Question: Summarize what this figure shows in one sentence.
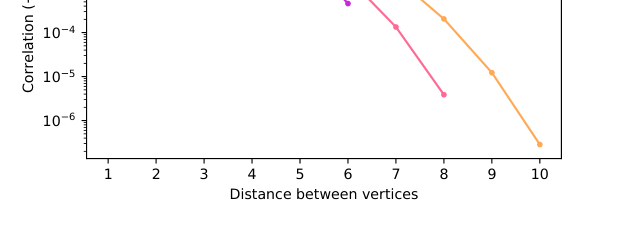
Answer: Long-range antiferromagnetic correlation coefficient on the 3-regular Bethe lattice, which is a proxy for an N →∞ typical 3-regular graph. Horizontal indexes the distance be- tween two vertices. QAOA is strictly local, which implies that no correlations exist between vertices a distance > 2p away. As shown here, however, these correlations are exponentially decaying with distance. This suggests that even if the QAOA ‘sees the whole graph’, one can use the central limit theorem to argue that the distribution of QAOA performance is Gaus- sian with the standard deviation of ∝1/ √